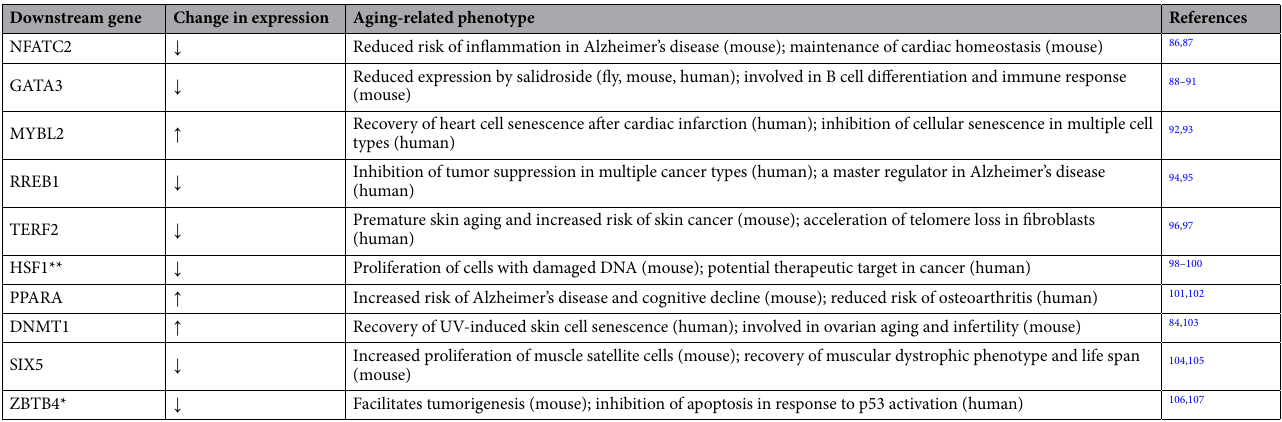
Table 2. Aging-related phenotypes regulated downstream of JUN. *Downstream genes that appeared to be regulated in the direction of accelerating aging or promoting aging-related